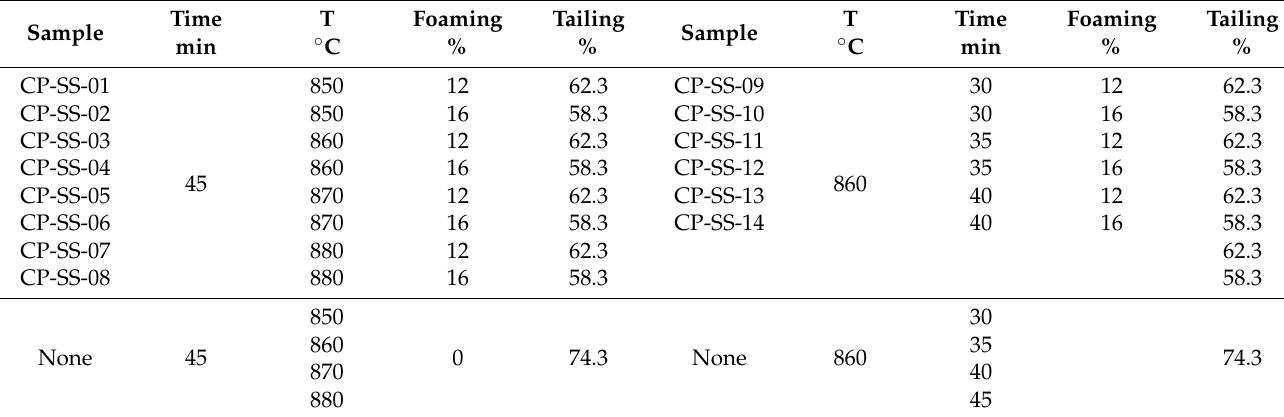
Table 1. Experimental test of samples elaborated from Ch é pica tailing and sodium silicate for the study of the influence of the sintering time.